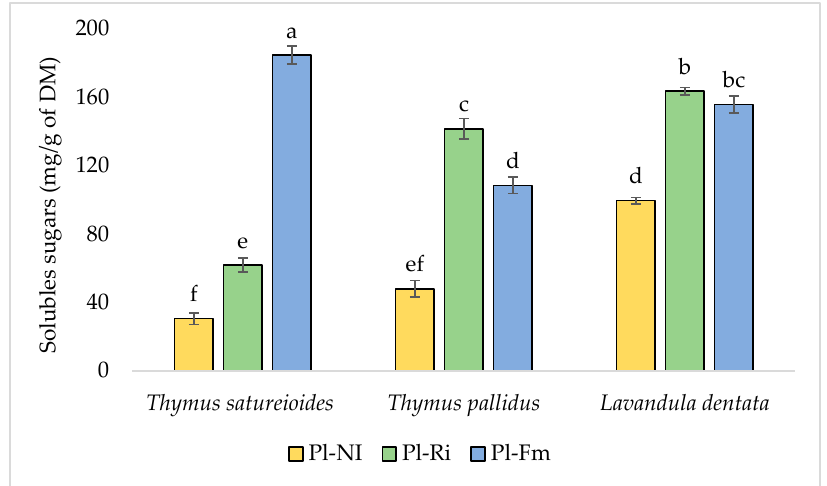
Figure 3. Chlorophyll content (mg/g DM) in Thymus satureioides (Ts), Thymus pallidus (Tp), and La- vandula dentata (Ld), non-inoculated (NI) or inoculated with Rhizophagus irregularis (Ri) or Funneli- formis mosseae (Fm) after 4 months of culture under greenhouse conditions Bars followed by the same letter are not significantly different according to Tukey’s HSD test ( p < 0.05). The total soluble sugar content significantly increased ( p < 0.0001) in I-AMP com- pared to their respective NI-AMP, regardless of the AMF strain or AMP species used. It varied between 62.2 and 185, 108.7 and 141.9, and 156 and 163.9 mg/g DM in mycorrhizal plants of T. satureioides , T. pallidus , and L. dentata , respectively, and did not exceed 30.7, 48.3, and 99.8 mg/g DM in their corresponding NI-AMP. The total soluble sugar content was 6 times higher in Ts-Fm, 2.2 times higher in Tp-Ri, and 1.5 times higher in Ld-Ri and Ld-Fm compared to NI-AMP (Figure 4).